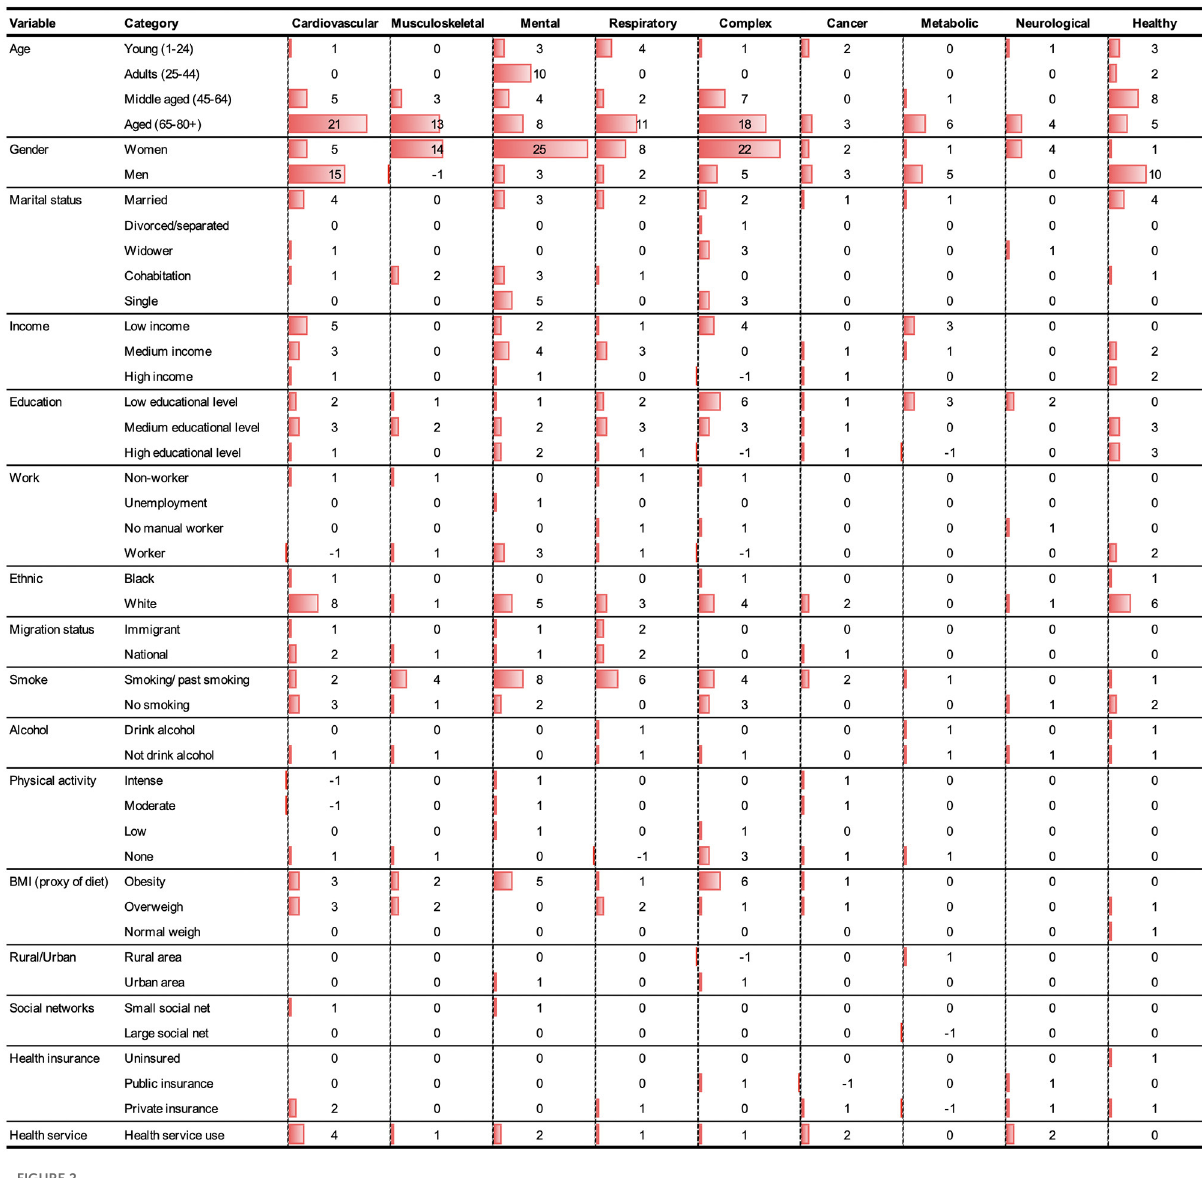
FIGURE2 Number of associations identified between different social determinants and the main multimorbidity patterns.